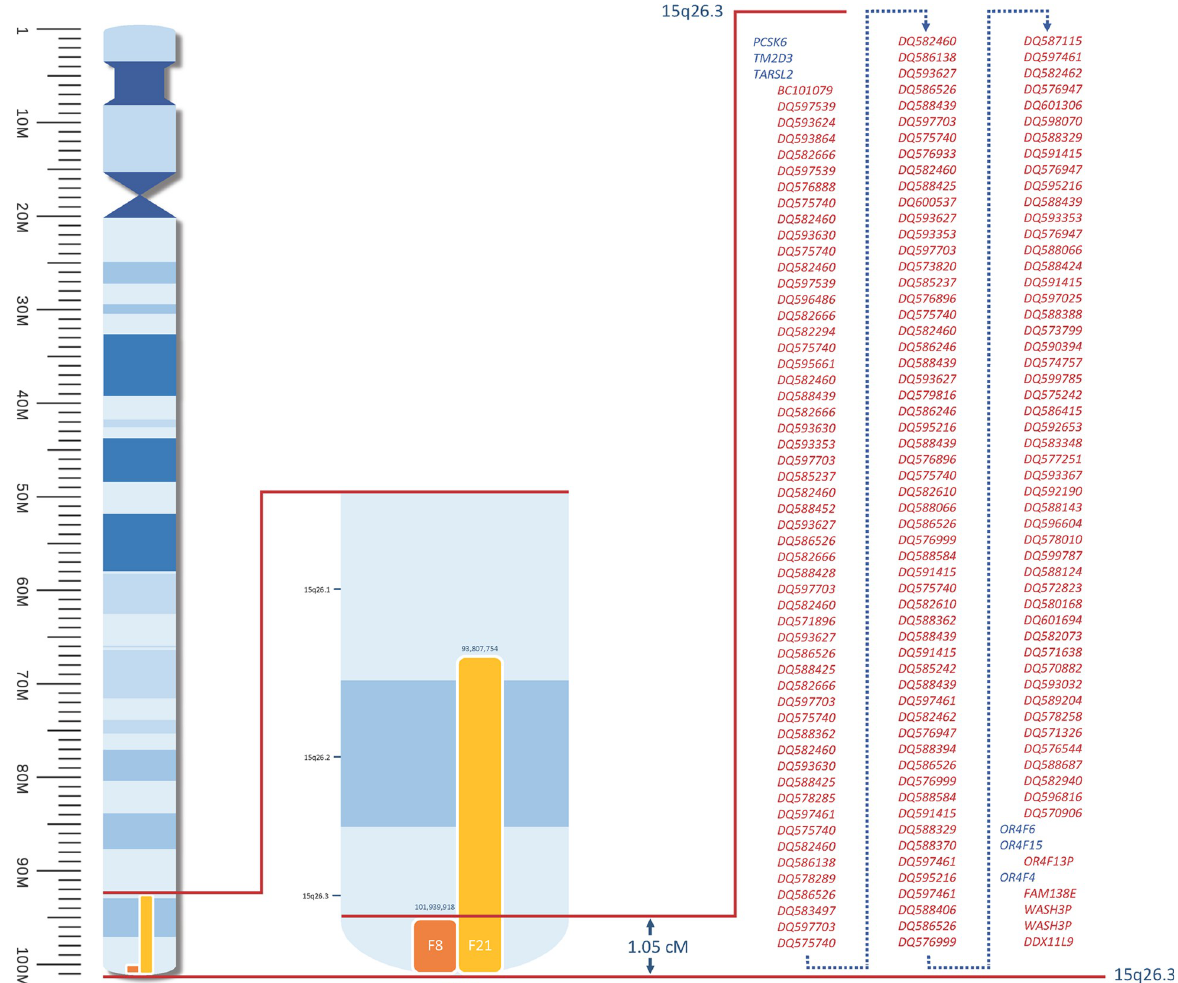
Fig 4. Candidate loci on chromosome 15. Coloured bars = loci supported by individual families; figures above and below these loci = physical (bp) position; bp = base pairs; M = mega base pairs; cM = centimorgan; red lines = enlarged overlap area; blue = protein-encoding genes; red = non-protein-encoding elements. All genes and positions in relation to GRCh37.p13 (hg19).